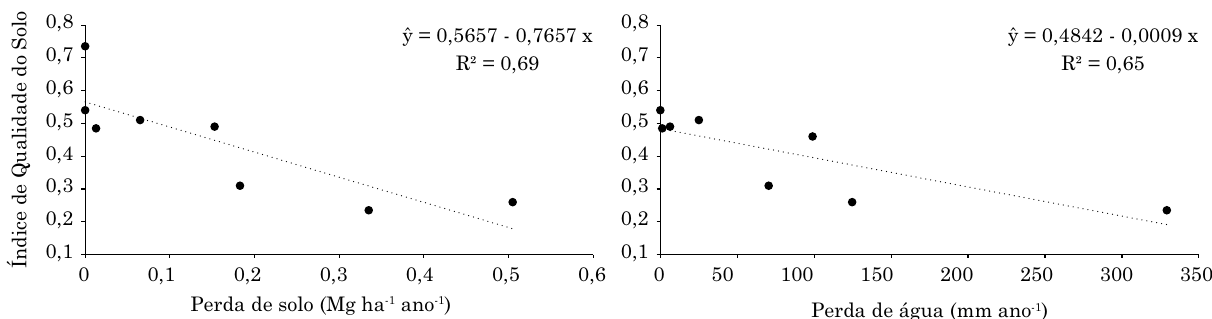
ŷ = 0,5657 - 0,7657 x R² =